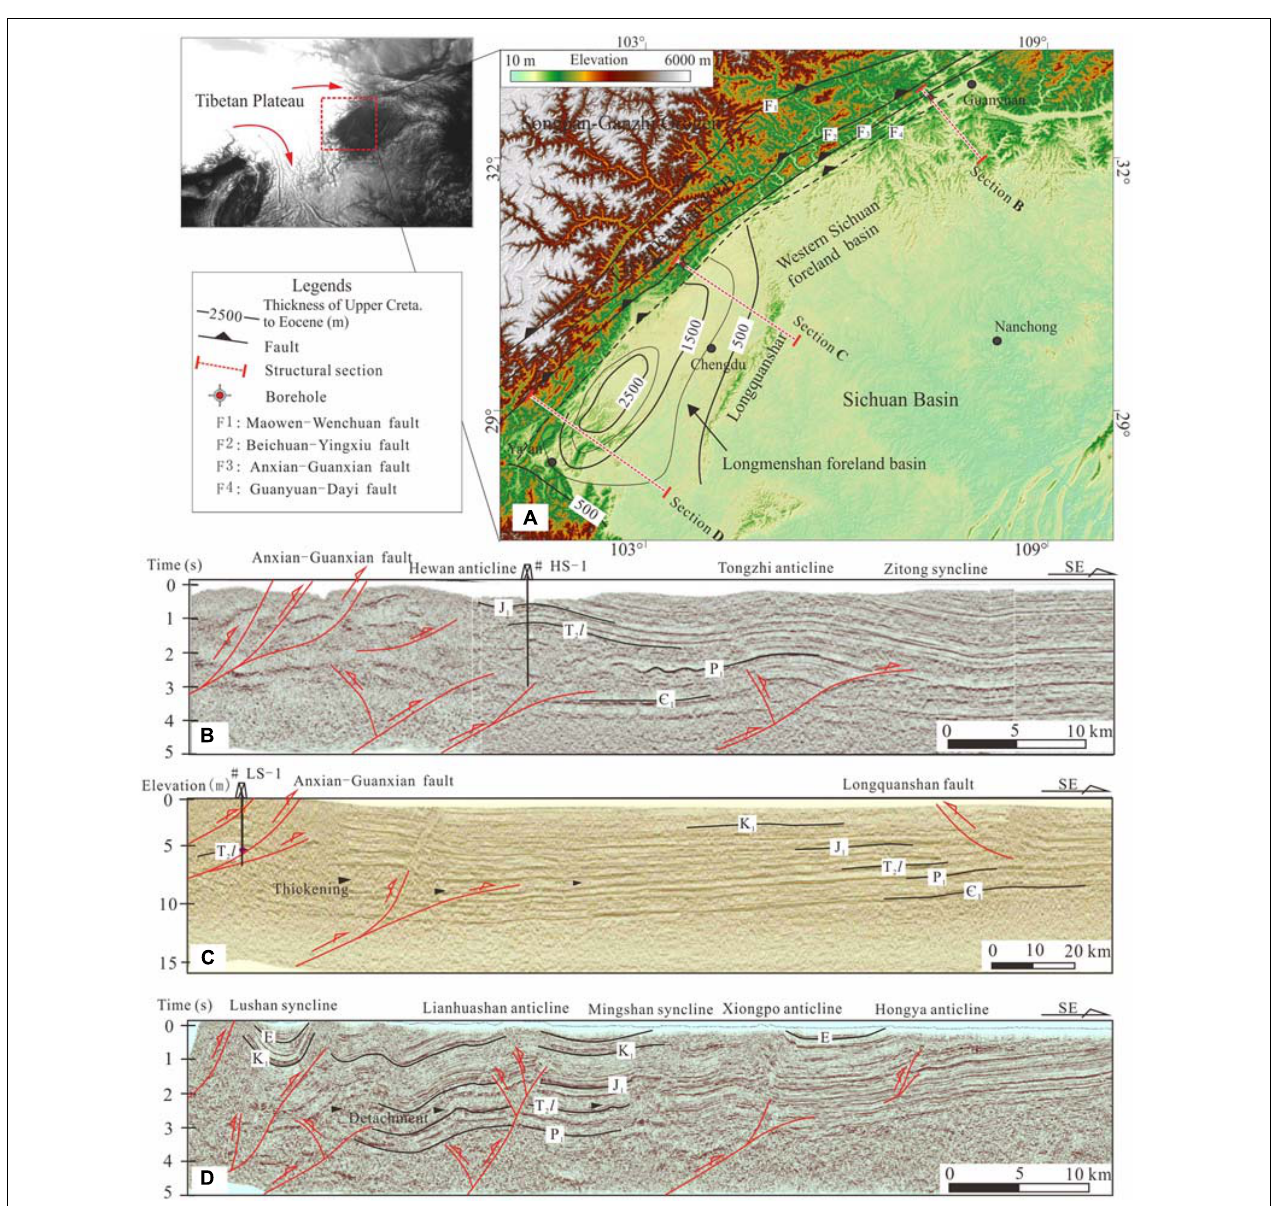
FIGURE 11 | Natural example of the Longmenshan fold-and-thrust belt in the eastern margin of the Tibetan Plateau. (A) Topography of Longmenshan FTB (fold-and-thrust belt) with the thicknesses of upper Cretaceous to Eocene showing Longmenshan foreland basin. (B–D) Structural sections indicate different style of deformation occurred in the northern, middle, and southern segments of the Longmenshan